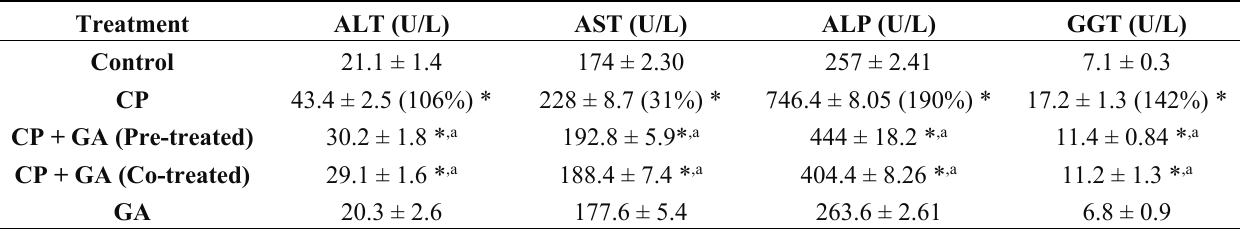
activities of plasma alanine aminotransferase (ALT), aspartate aminotransferase (AST), alkaline phosphatase (ALP), and gamma glutamyl transferase (GGT) in